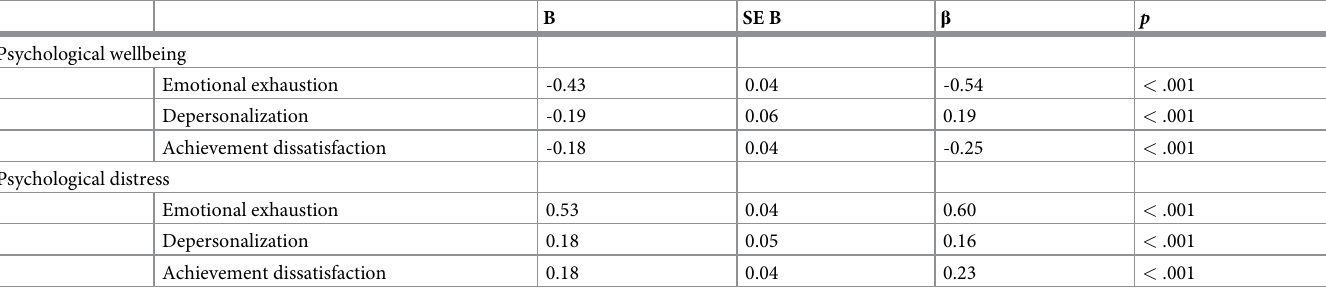
Table 3. Path analysis regression weights of burnout on mental health